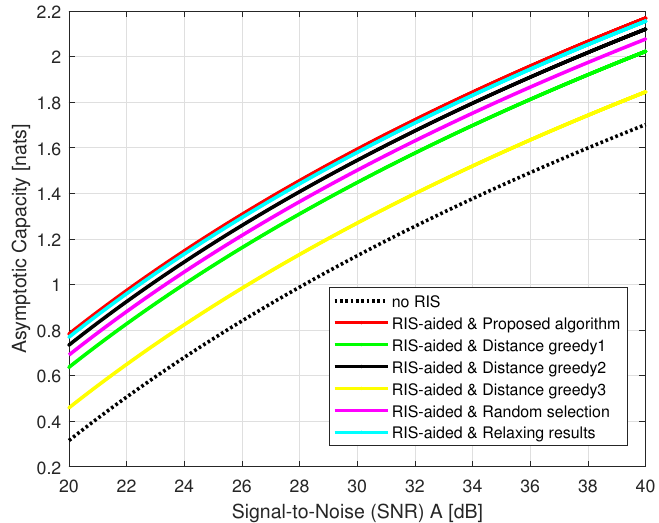
Figure 3. Asymptotic capacity versus different SNR with different assignment schemes, K =